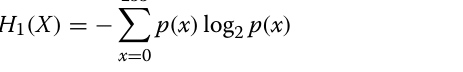
The TE based on the above can describe the compre- hensive features of the grayscale information of the pixel and the grayscale distribution in the neighborhood of the pixel. We determined the TE for a reference image ( monarch . bmp in the LIVE [50] database) and the five corresponding distorted images with the same distortion level but different distortion types. The statistical char- acteristics are shown in Fig. 3a and b. All the differential mean opinion score (DMOS) [53] values are around 25 in Fig. 3a and 50 in Fig. 3b, and the distortion types span JPEG and JP2K compression, additive white Gaussian noise (WN), Gaussian blue (GBlur), and fast fading (FF) Rayleigh channel distortion. Similarly, the same experi- ments were carried out on monarch.bmp and the five corresponding distorted images with the image distortion type but different distortion levels (taking WN and GBlur as examples), whose statistical characteristics are shown in Fig. 3c and d. In Fig. 3, the abscissa axis represents the entropy and the vertical axis represents the normalized